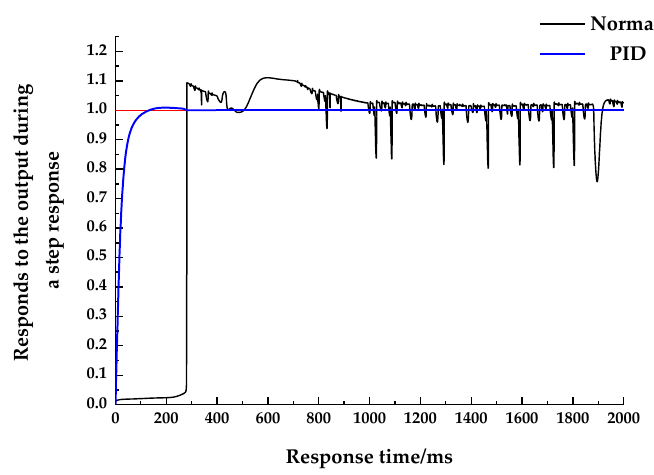
Figure 12. PID control and unregulated step response curve.